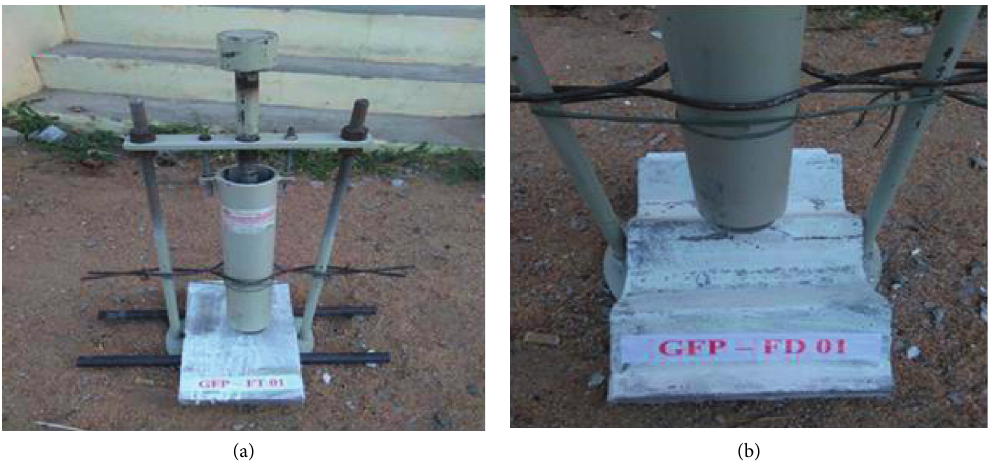
Figure 10: Drop-weight impact test on GF panels. (a) Test on flat panel. (b) Test on folded panel.